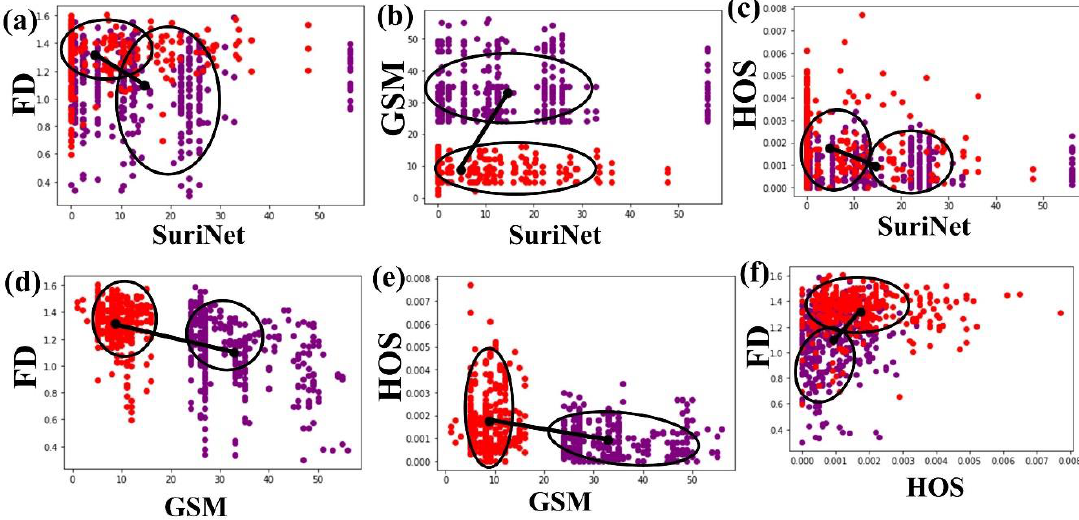
Figure 17. ( a – c ) The symptomatic image heatmaps vs. original images; ( d – f ) the asymptomatic image heatmaps vs. original images (red color arrow represents the important regions).